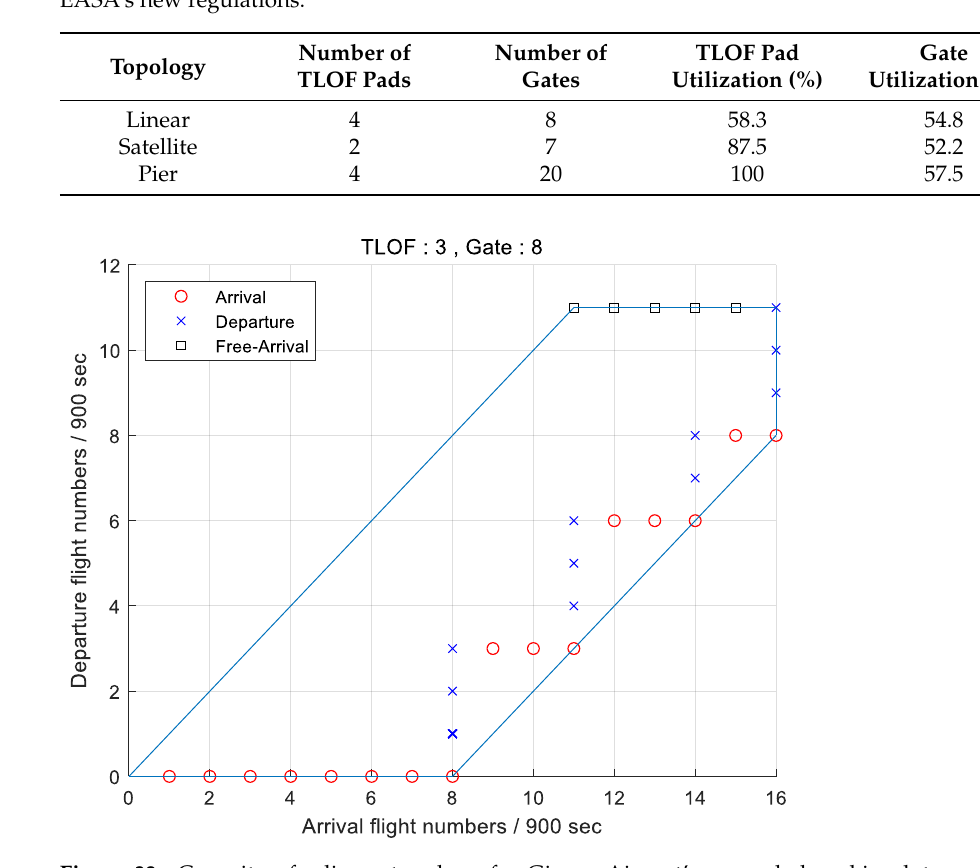
Figure 35. Capacity of a pier topology for Gimpo Airport ’s expanded parking lot space that complies with the FAA’s new regulations.